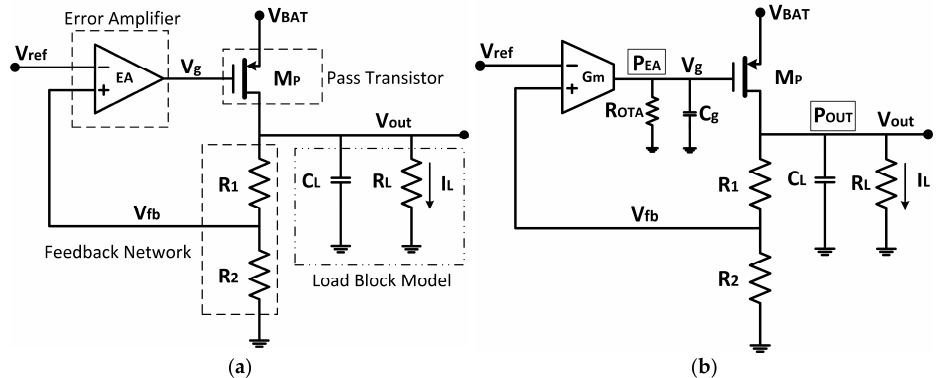
Figure 2. ( a ) Basic LDO voltage regulator topology; and ( b ) single stage OTA EA implementation.